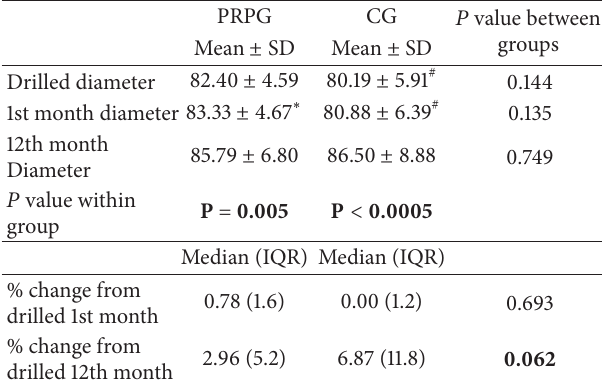
Table 1: Comparison of mean tunnel diameter between groups during the observation